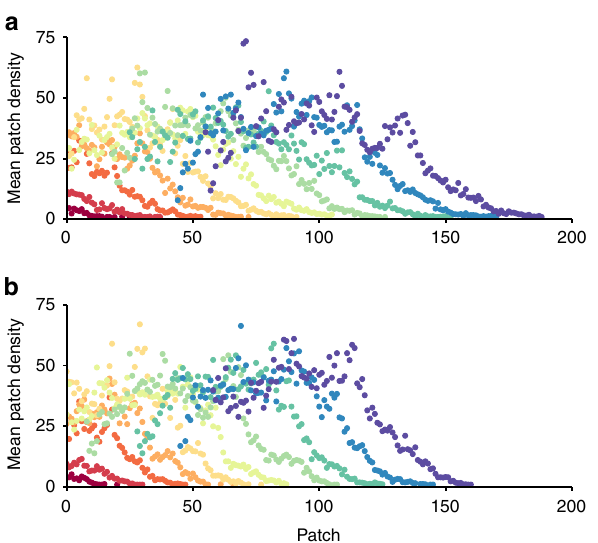
Figure 1 | Wave-like expansion of experimental beetle invasions. Points show the mean population density of each patch, averaged across replicates, for ( a ) spatially sorted and ( b ) spatially shuffled invasions (nine replicates each). Invasions spread from left to right across the x axis (patch number) over time so that each coloured wave represents a different invasion generation. On average, spatially sorted replicates travelled farther and faster than shuffled replicates after 10 generations.